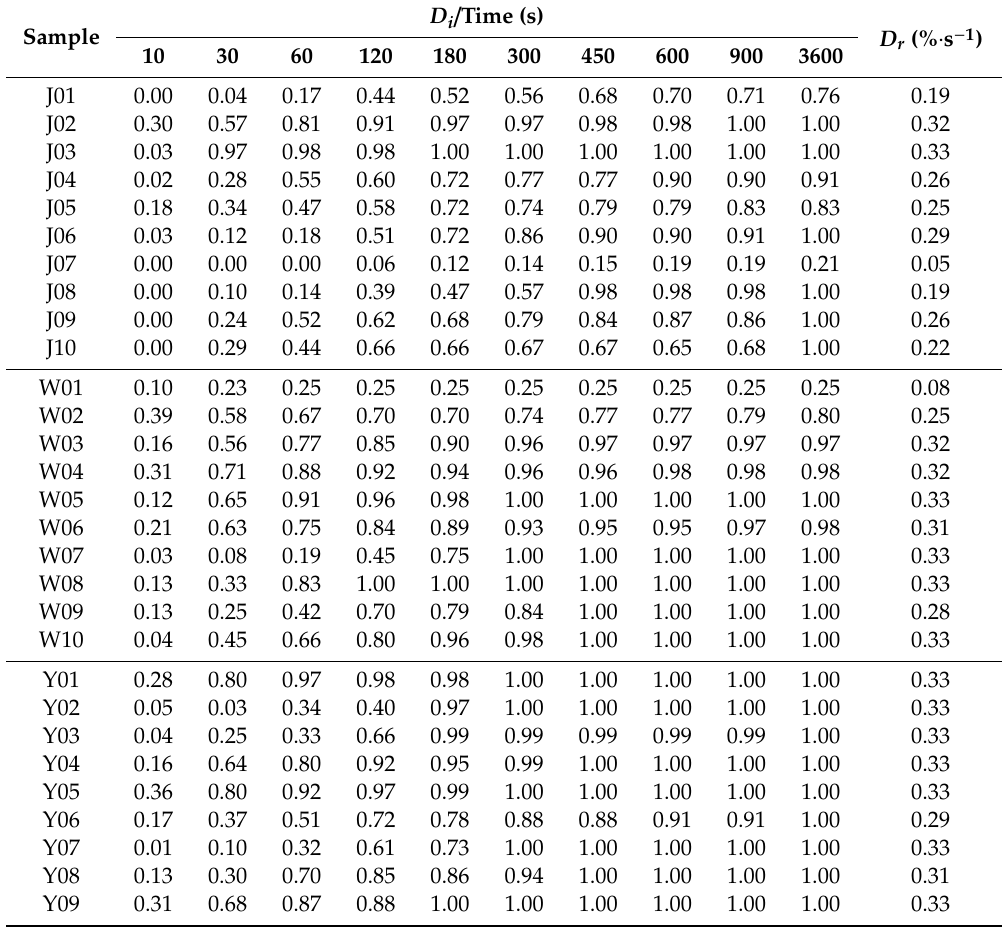
Table 4. The soil disintegration rate ( D r ) and disintegration index ( D i ) of plinthosol.